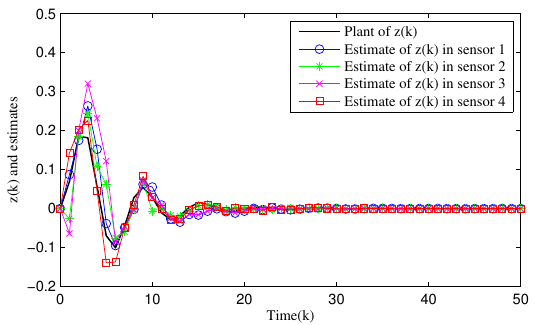
Figure 7. Evolution of reduced-order filtering ˆ z i ( k ) , i =